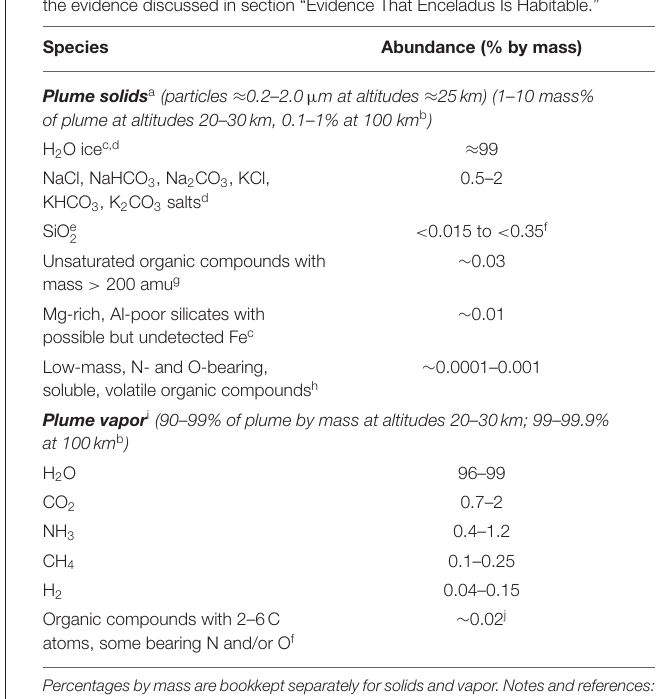
TABLE 2 | Expected major constituents of Enceladus plume samples based on the evidence discussed in section “Evidence That Enceladus Is